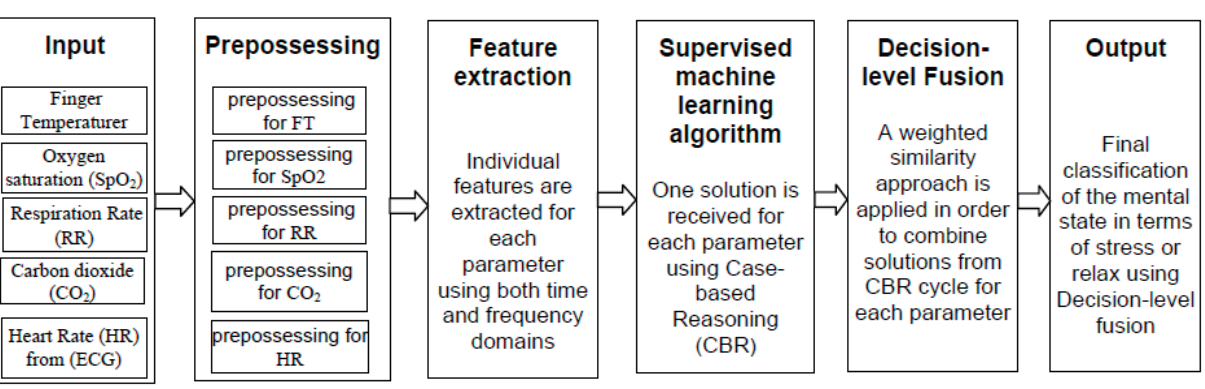
Figure 3. An overview of the classification scheme to identify mental state in terms of Stressed or Relaxed considering the decision-level